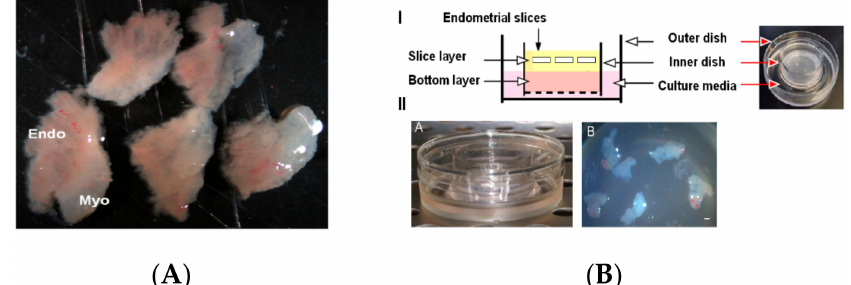
Figure 1. Artificial 3D cell culture model system for endometrial slice culture. ( A ) Slices from full thickness human endometrium. ( B ) I- Schematic representation of double-dish model system for ex vivo culturing of endometrial slices. ( B ) II- Representative images showing endometrial tissue slices grafted onto the surface of a 30-mm inner dish in Cellmatrix Type I-A, Nitta Gelatin with the help of a hydrophilic polytetrafluoroethylene membrane while the 60-mm outer dish contains the 3D cell culture medium. Myo, myometrium; Endo, endometrium. Scale bar = 1